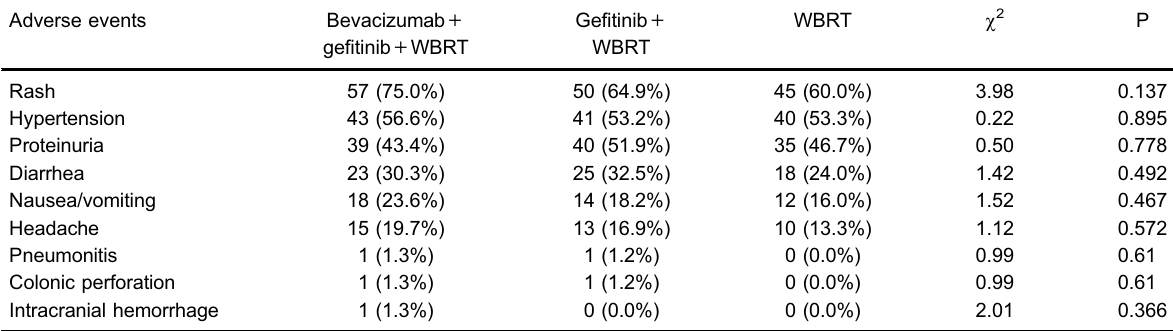
Table 3. Rate of adverse events in patients with brain metastases due to non-small-cell lung cancer treated with bevacizumab + ge fi tinib + WBRT, ge fi tinib + WBRT and WBRT. Adverse events